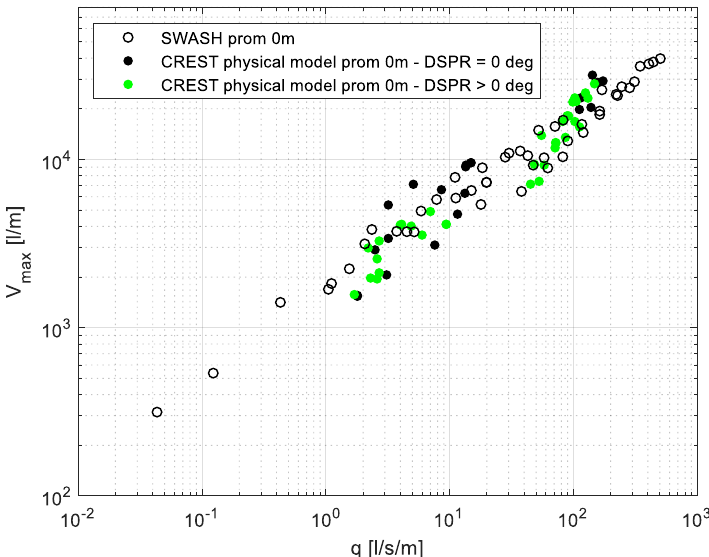
Figure 11. Comparison between DSPR = 0 and DSPR > 0 of physical models on q-V max (Average overtopping discharge - maximum individual overtopping volume) for the case of promenade width 0 m.